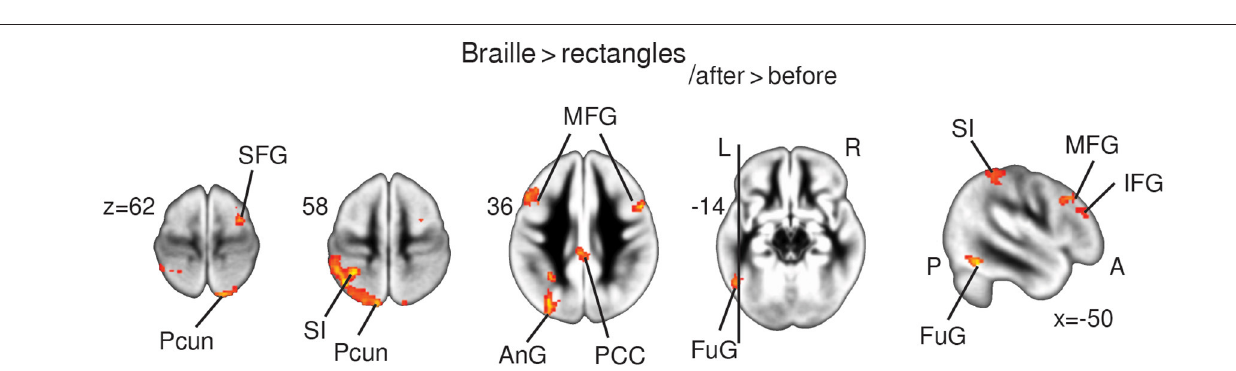
Braille Characters Discrimination Task > Rectangles after >